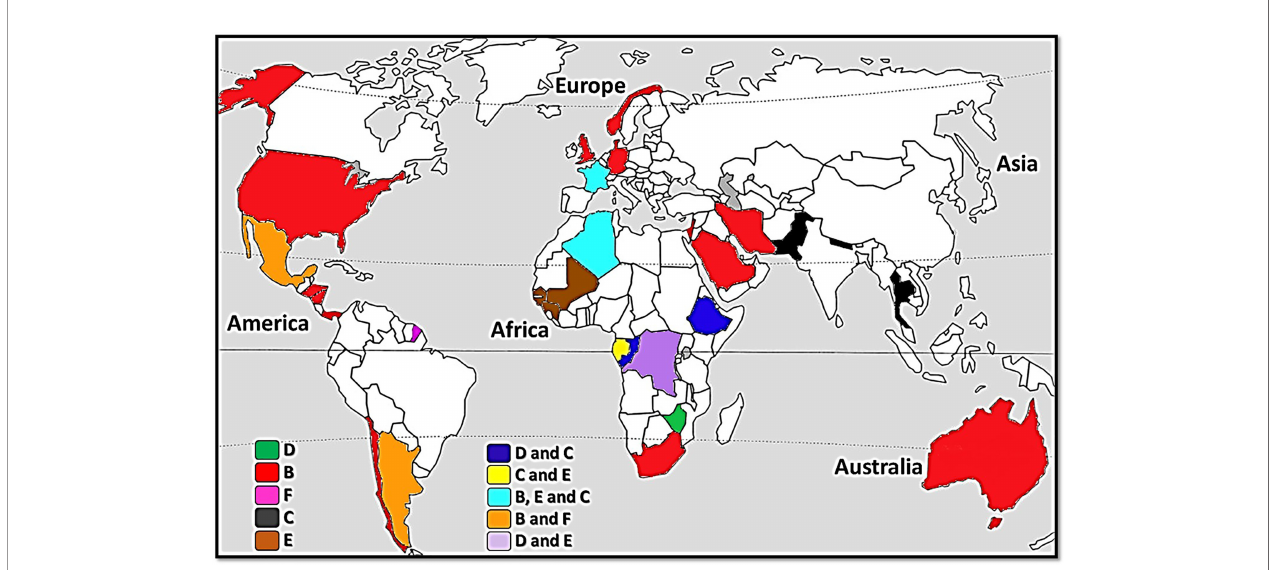
FIGURE 1 | A map of the world showing the distribution of Pediculus humanus